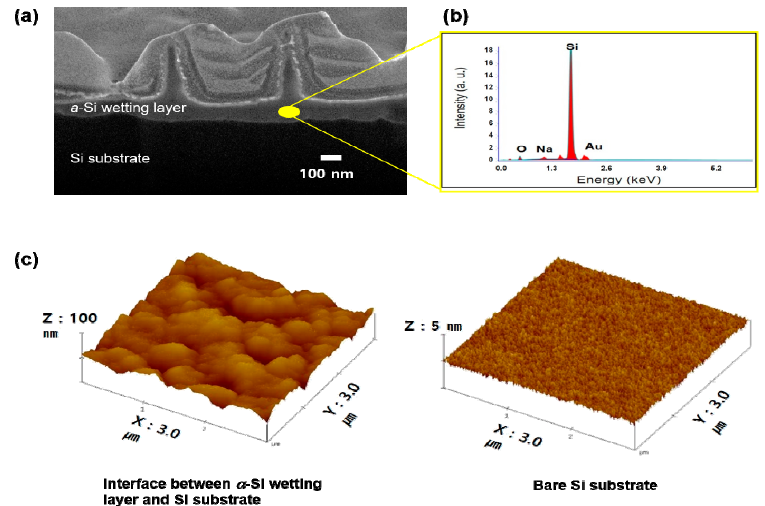
Figure 3. ( a ) Focused ion beam (FIB)-SEM image of the a -Si nanotips on a silicon substrate. ( b ) EDX spectrum of a -Si wetting layer at the yellow point in ( a ). ( c ) 3 × 3 μ m 2 atomic force microscopy (AFM) images of the interface between the a -Si wetting layer and Si substrate (left) and the surface of a bare Si substrate (right).